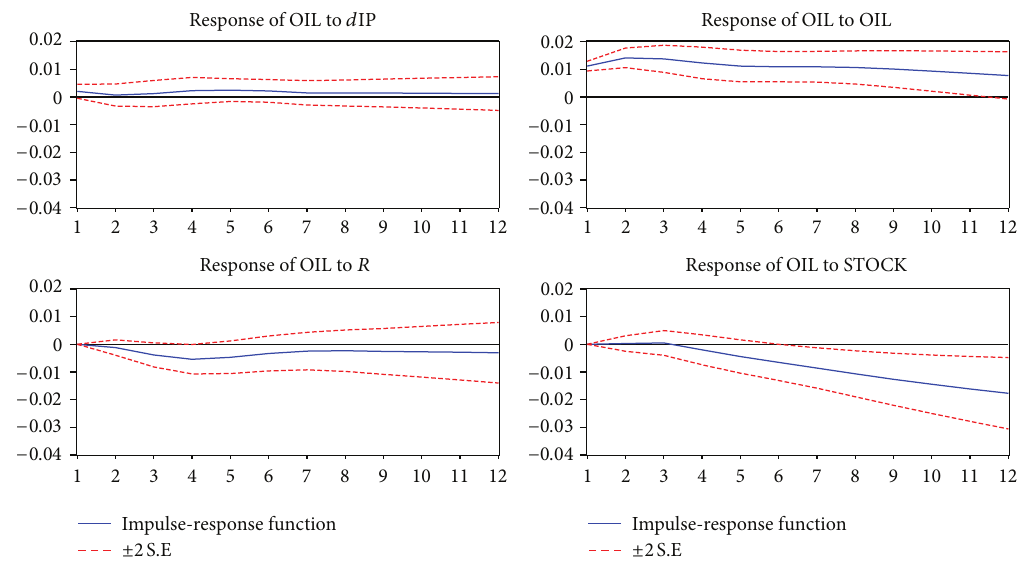
Figure 2: Generalized impulse responses of energy price to one S.D. shock for other variables changes. Note that the horizontal axis is the period. The vertical axis is the explanation level of dependent variables to independent variables. In the model, we fix the periods at 12